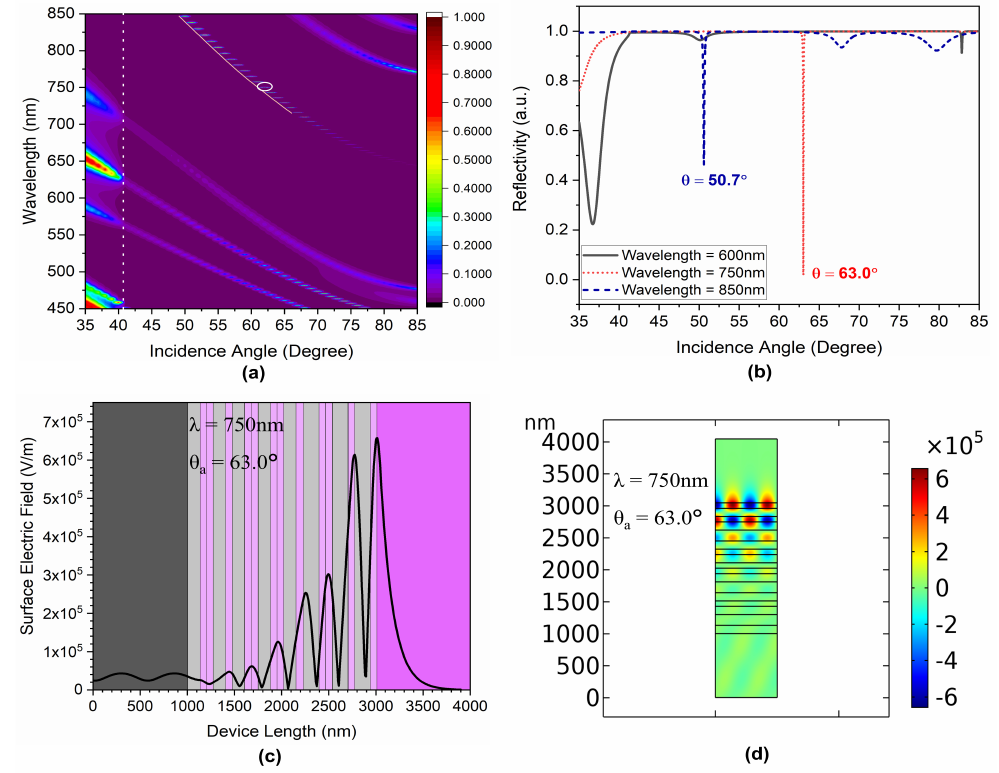
Figure 3. Transmission characteristics of the proposed structure at an oblique incidence angle for n = 6 QPhC: ( a ) angular dispersion characteristic, ( b ) angular reflectance characteristic, ( c ) normalized sur- face electric field confinement along with the length of the proposed structure, and ( d ) corresponding spectral electric field distribution and mode